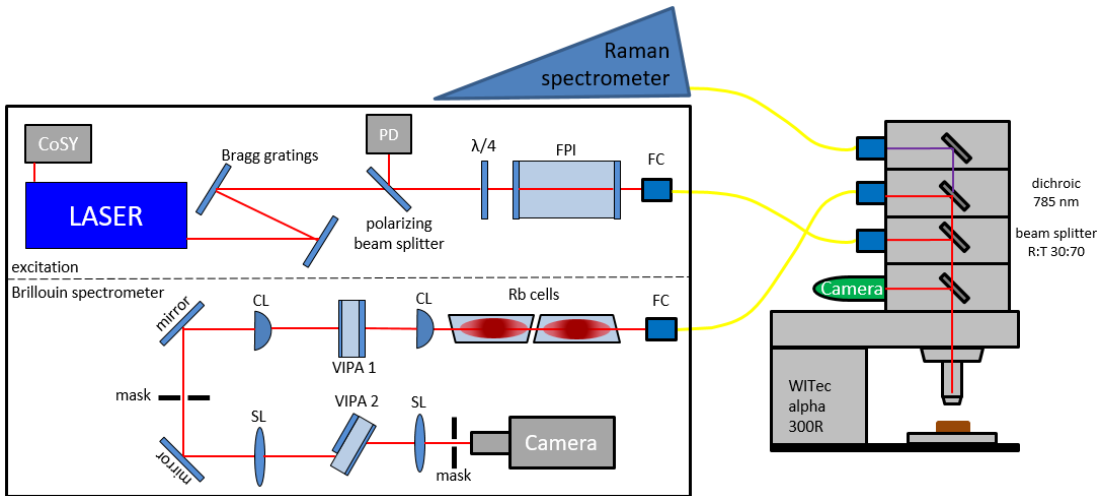
Fig. 1. Scheme of the experimental setup showing the excitation, the confocal microscope and both spectrometers. CoSY: Compact Saturation Spectroscopy, PD: Photodiode, FPI: Fabry-Pérot, FC: fiber coupler, CL/SL: cylindrical spherical